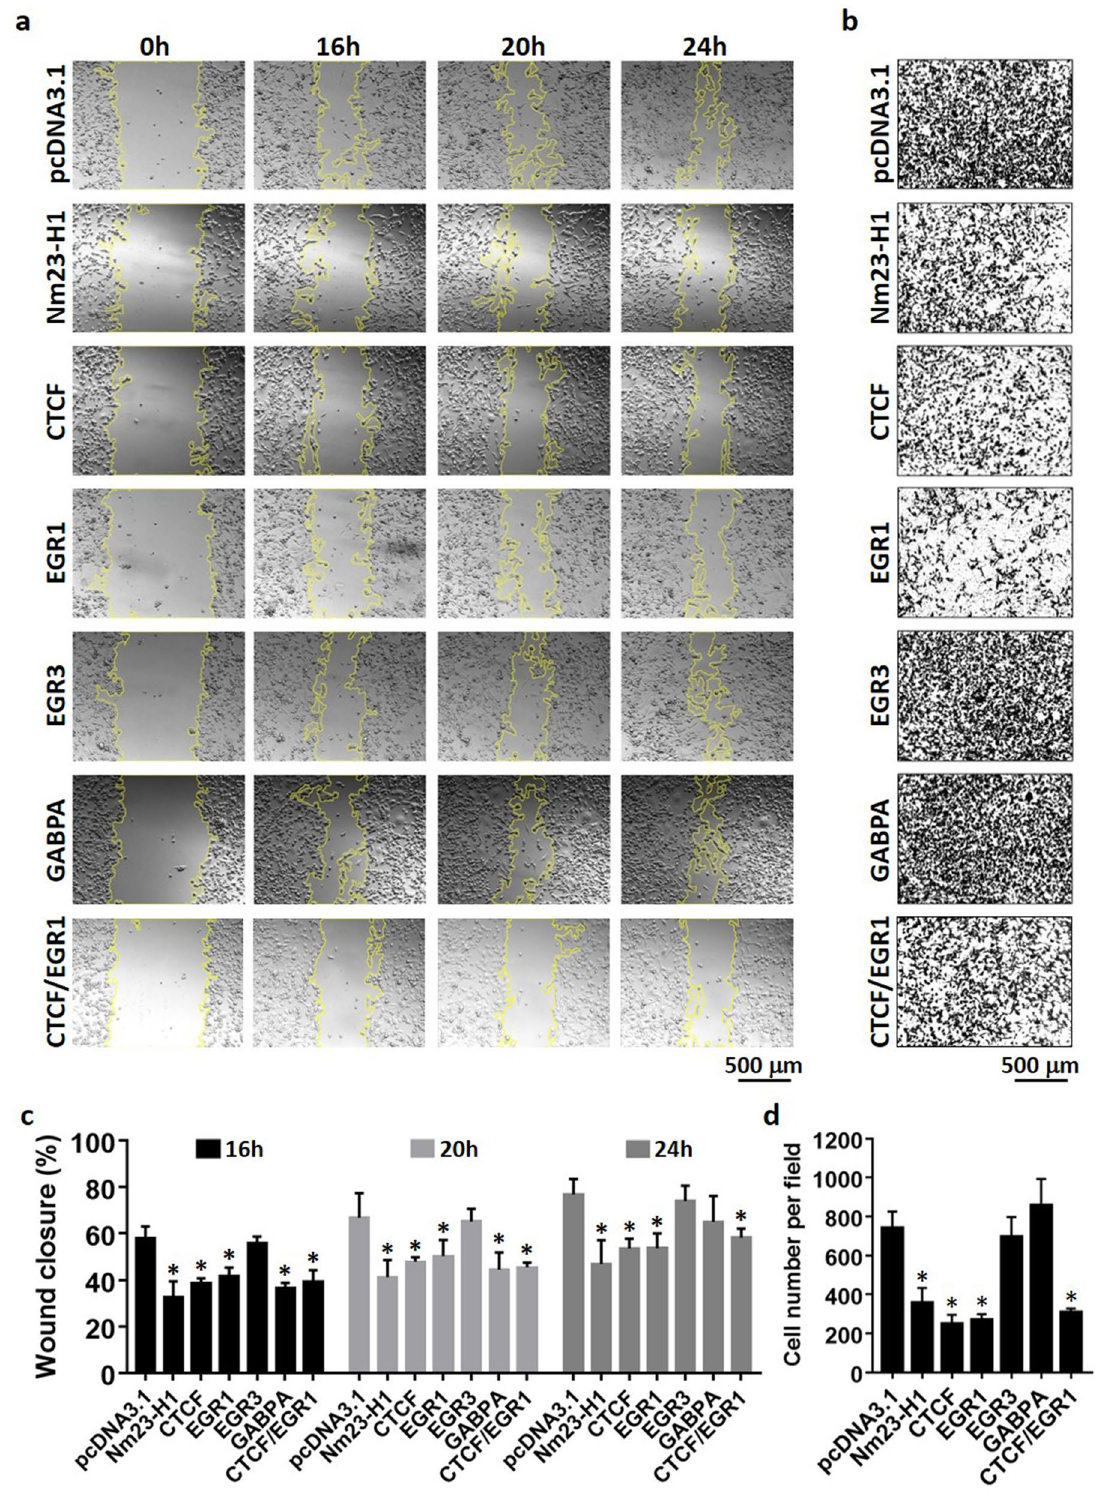
Figure 6. Cell migration of MDA-MB-231 cells expressing transcription factors. ( a , c ) Transiently transfected cells were grown to full confluency and scratched with a yellow pipette tip. Photos were taken at different time points with a microscope at ×10 magnification. Cell migration was quantified as percentage of wound closure using ImageJ and MRI Wound Healing Tool plugin. ( b , d ) Transiently transfected cells were seeded into the upper chamber of Transwell inserts and allowed for migration for 16 h. Photos were taken with a microscope at ×10 magnification and the number of migrated cells was quantified using ImageJ. Data represent the mean and standard deviation of three independent trials. *Significance with pcDNA3.1, p <